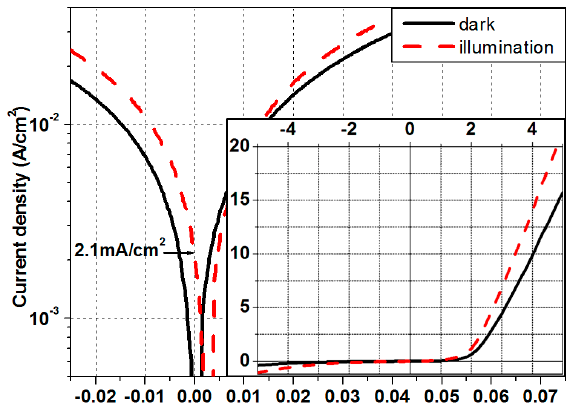
Figure 5. Photoelectric properties of the p/n-Si DSL structures with seven p/n-Si junctions on 6H-SiC.